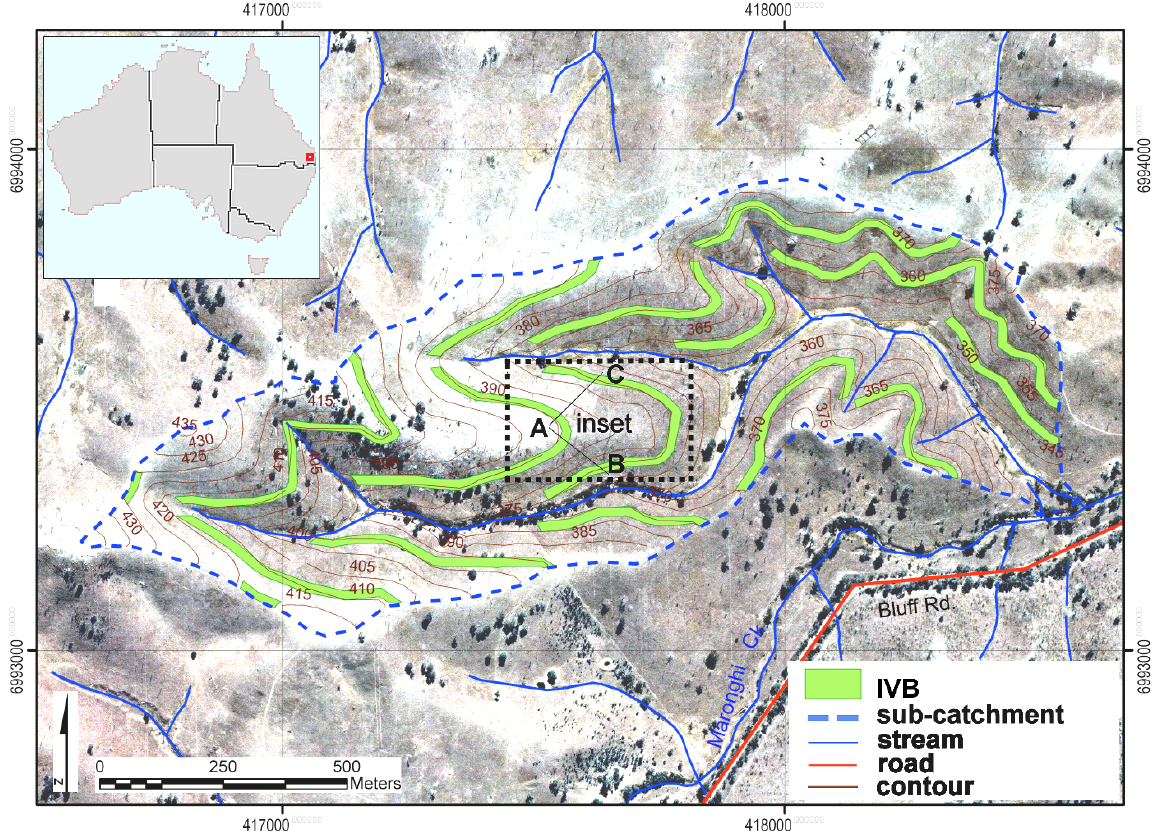
Figure 2. Location of Maronghi Creek sub-catchment showing contours, fluvial system and the existing land cover onto which IVB were applied. Note the inset which is comprised of a central ridge was selected for closer analysis of hillslope dynamics, including the two transects denoted as A-B and A-C (Coordinates are GDA 1994 MGA Zone